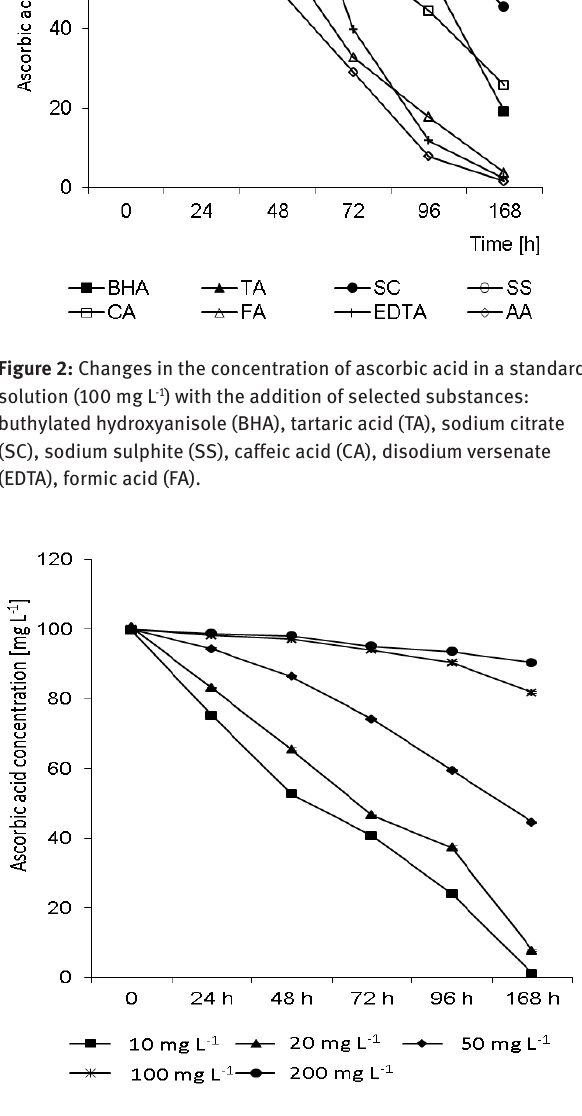
Figure 3: Changes of vitamin C concentration in standard solution (100 mg L -1 ) with an addition of tartaric acid (TA) (within the range of concentrations of 10-200 mg L -1 ) stored at room